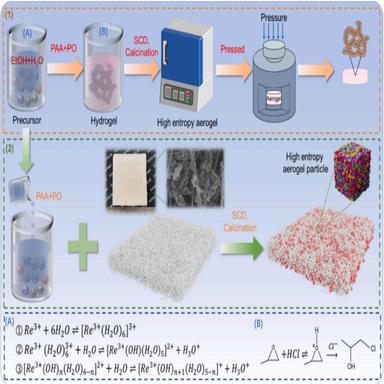
Schematic of the preparation process for (YErYbGdLa)2Zr2O7 ceramic aerogel.